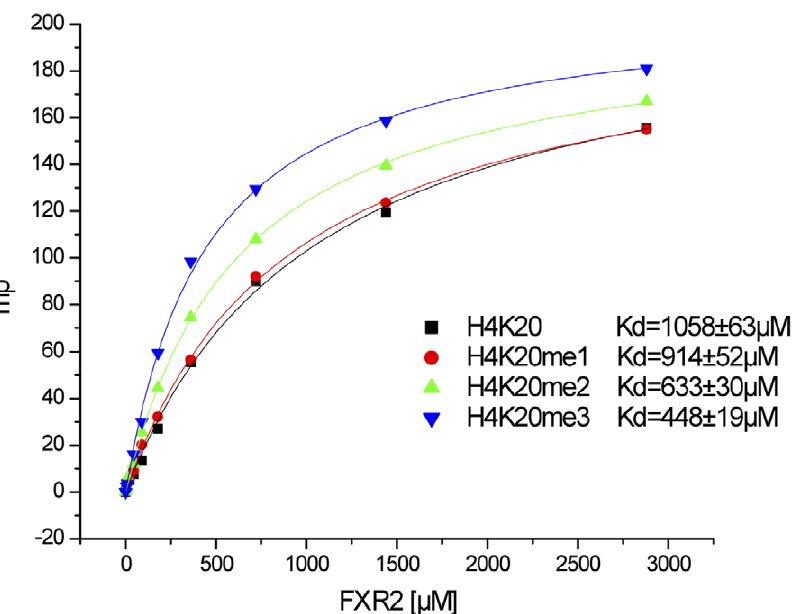
Figure 4. FXR1 and FXR2 preferentially recognizes trimethylated histone peptides. The fluorescence polarization binding curves for FXR2 and H4K20 peptides are shown as a example.